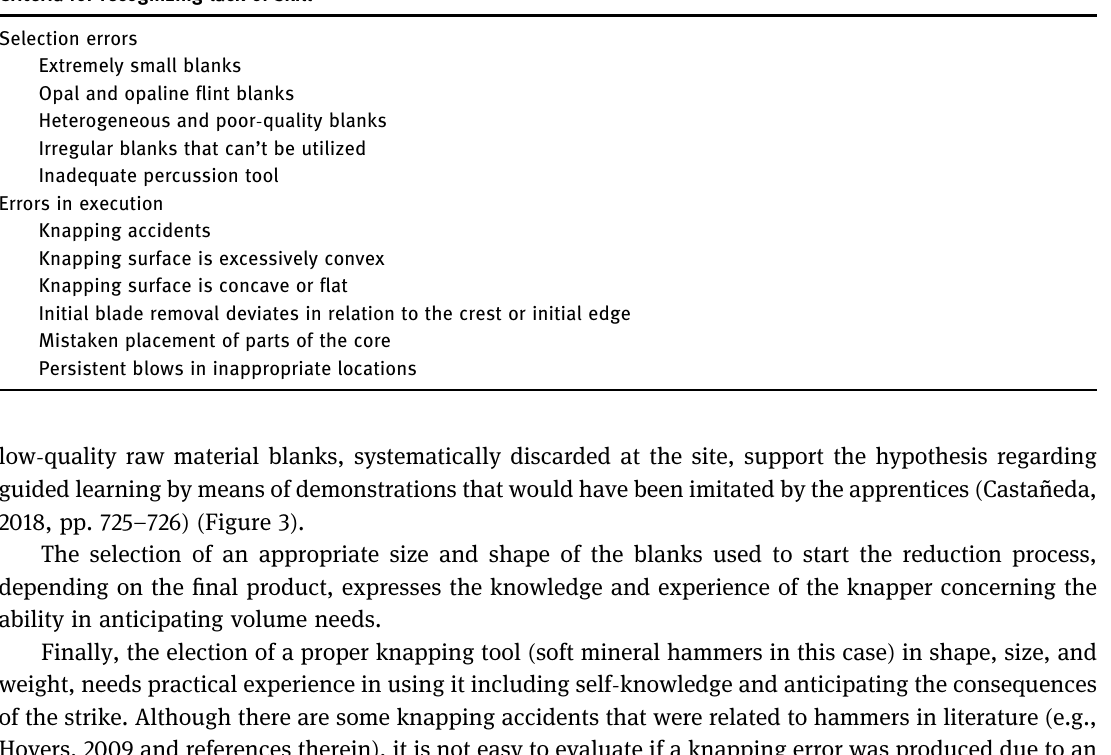
Criteria for recognizing lack of